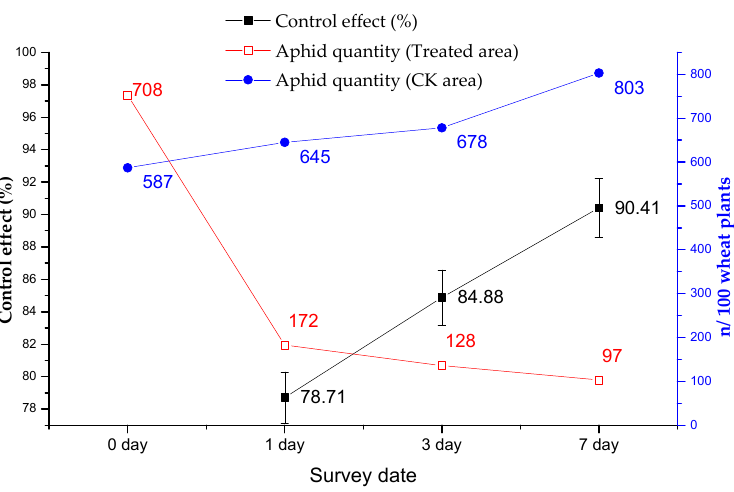
Figure 8. Wheat aphids control effect. Table 8. Control effects of powdery mildew and head blight.